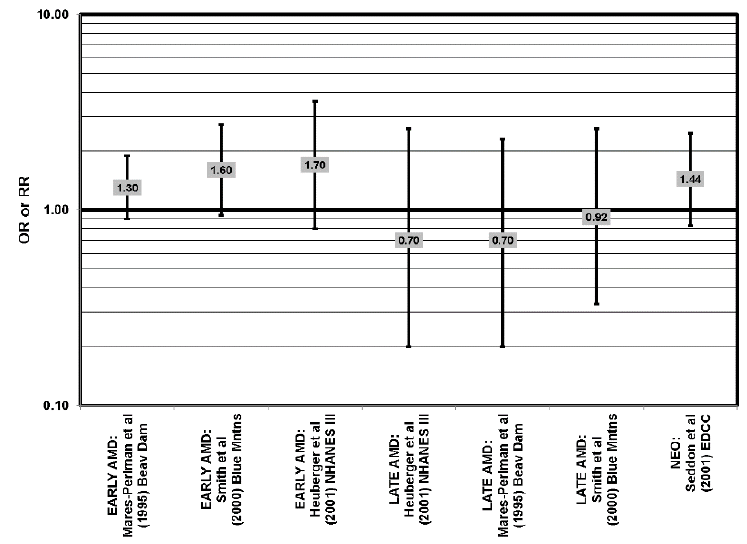
Figure 22. AMD odds or risk ratio; high vs. low intake of total fat: retrospective and cross-sectional studies.